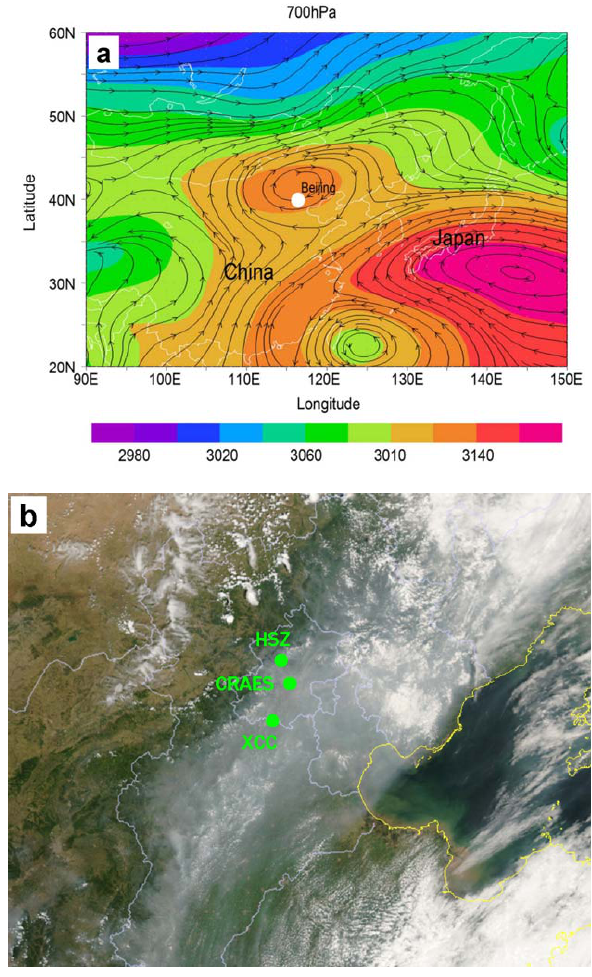
Figure 6. (a) Mean wind and geopotential height for a multi-day pollution episode on Fig. 6. (a) Mean wind and geopotential height for a multi-day pol- lution episode on 22–28 July 2008 (b) MODIS true-color imagery 22-28 July 2008 (b) MODIS true-color imagery on July 24. on 24